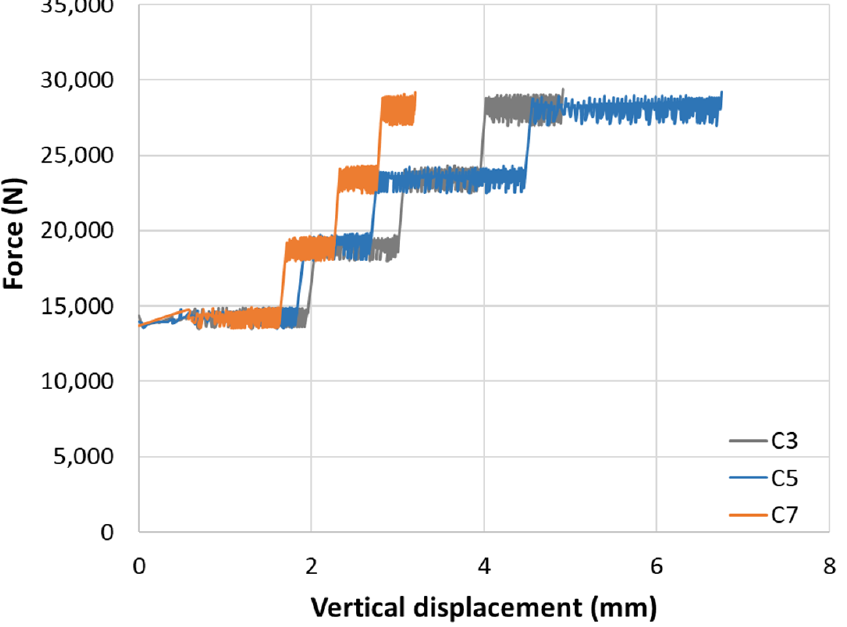
Figure 6. Force–displacement envelopes for the pavement system with different CBGM layers.